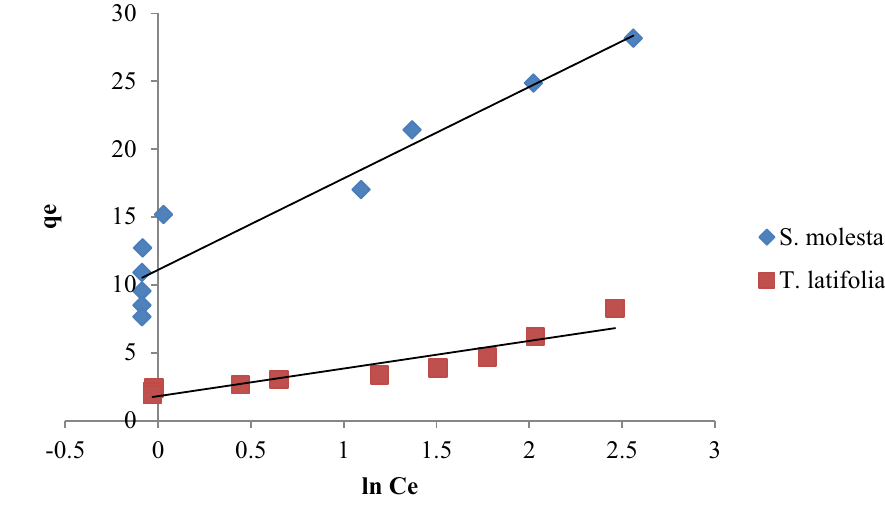
Fig. 12 Temkin plot for Cr 6+ adsorption on S. molesta and T. latifolia